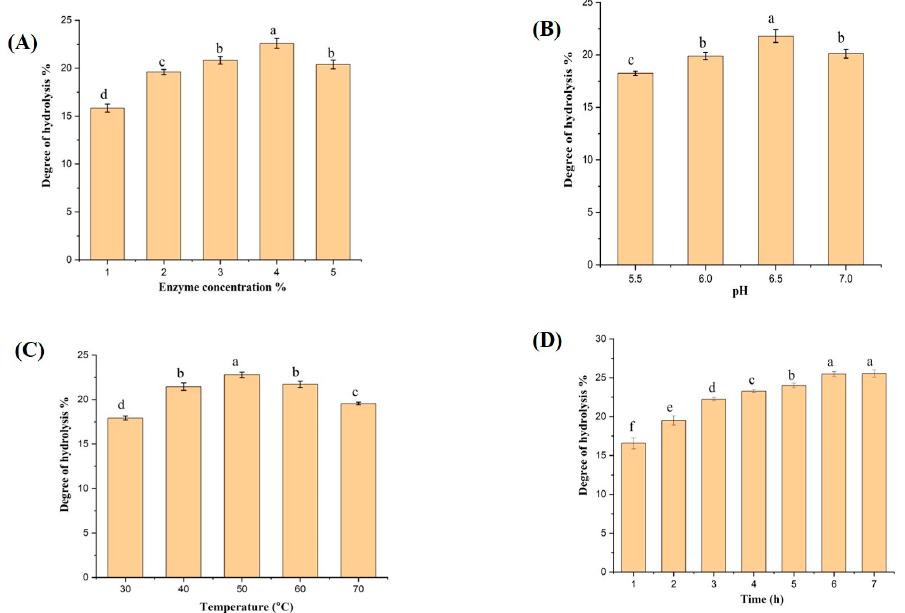
Figure 1. Influence of enzymatic hydrolysis conditions ( A ) E/S ratio; ( B ) pH; ( C ) temperature; and ( D ) time of hydrolysis reaction on degree of hydrolysis (DH). The values represent mean ± SD (n = 3), and the various letters indicate the values are significantly different ( p ≤